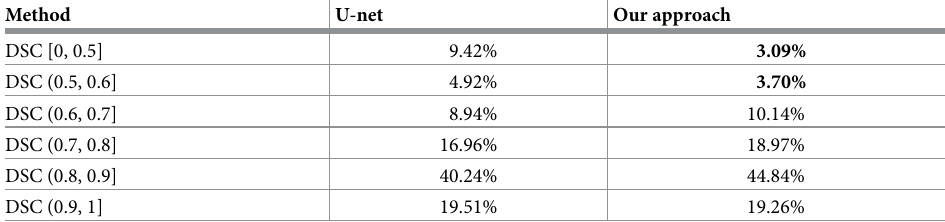
Table 4. Analysis of the DSC distribution of all